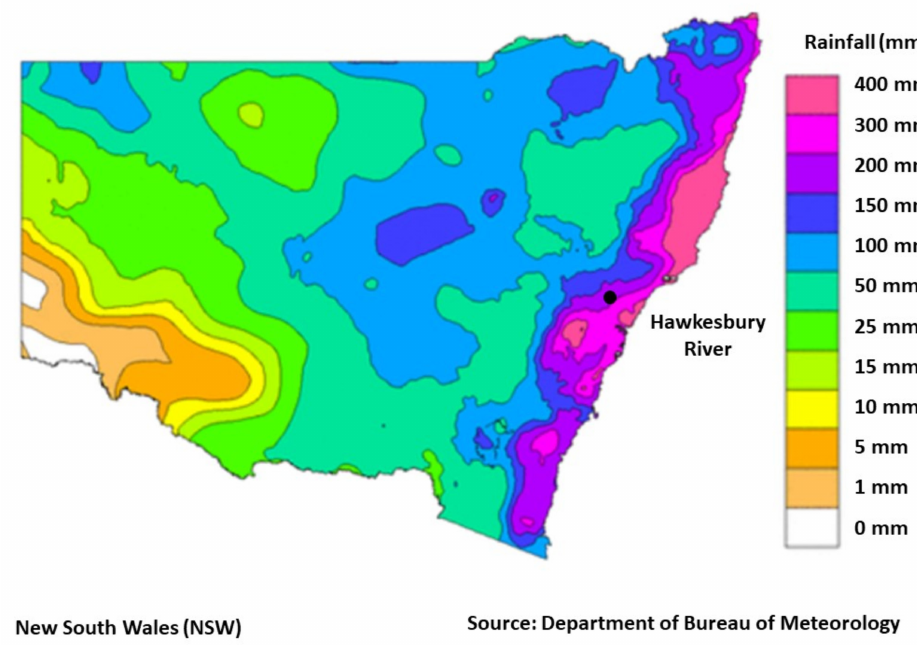
Figure 3. The NSW coast has been drowned by at least 200 mm, and in some places, more than 400 mm of